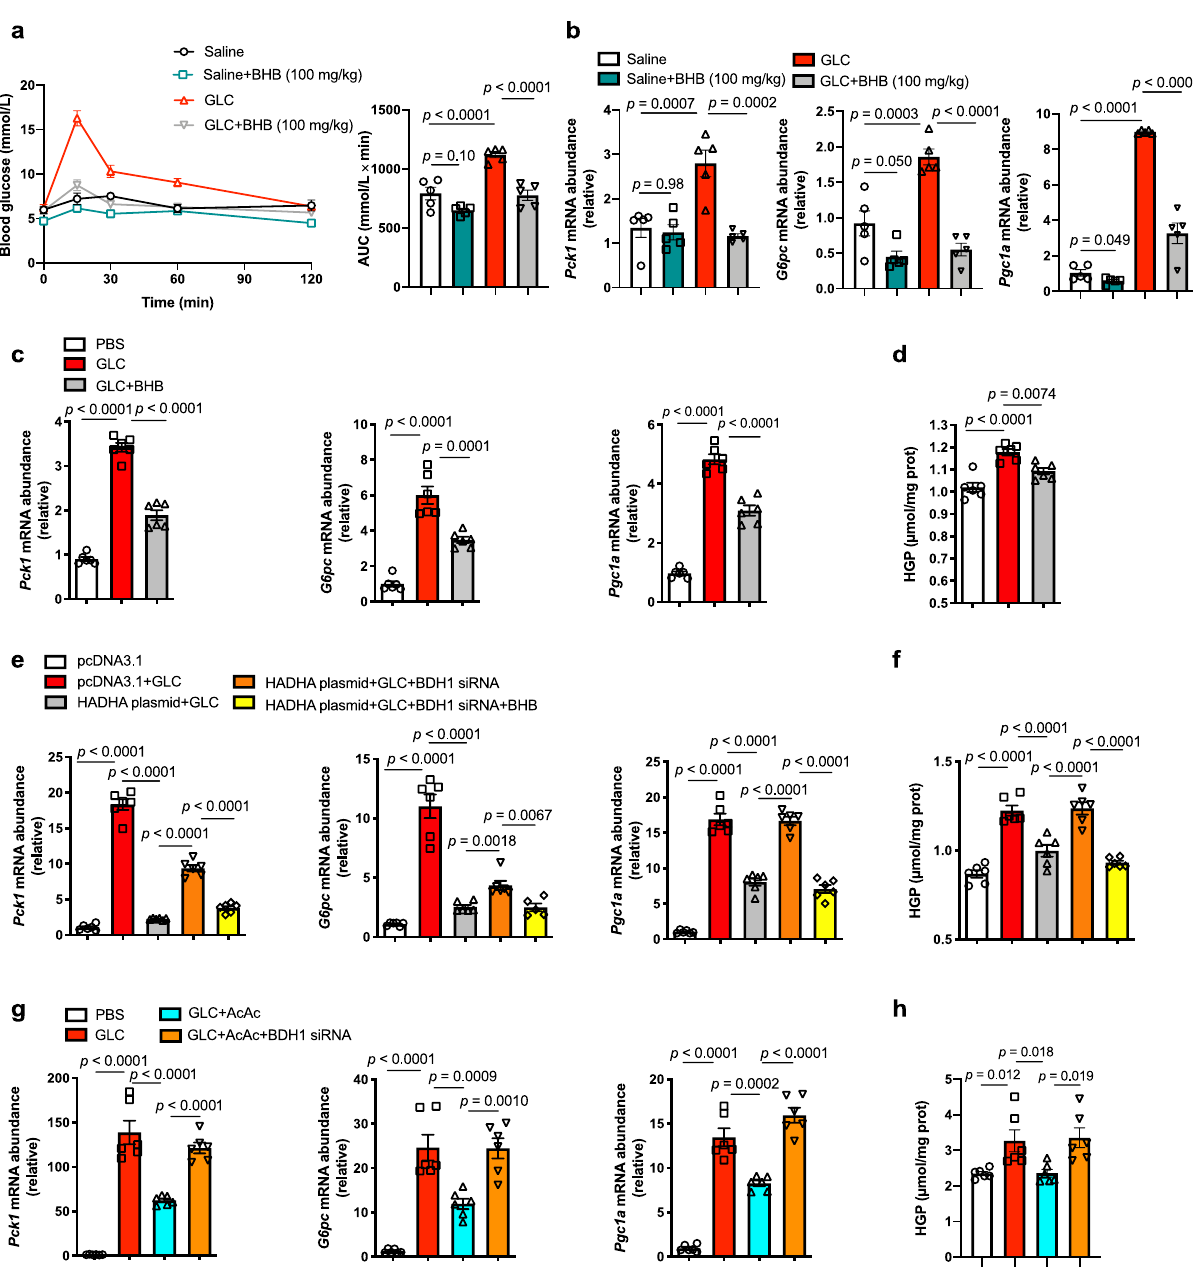
Fig. 3 BHB was responsible for the inhibitory effect of HADHA on hepatic gluconeogenesis. a Blood glucose levels in normal mice subjected to glucagon challenge (2 mg/kg) and those with BHB treatment (100 mg/kg). AUC is indicated on the right ( n = 5). b mRNA levels of Pck1 , G6pc and Pgc1a in the livers of the mice in a ( n = 5). c mRNA abundance of Pck1 , G6pc and Pgc1a in glucagon-stimulated (100 nM, 1 h) primary hepatocytes treated with or without BHB (400 μ M, 6 h, n = 5). d HGP from the hepatocytes in c ( n = 6). e Relative mRNA abundance of Pck1 , G6pc and Pgc1a in HADHA-overexpressed primary hepatocytes transfected BDH1 siRNA with or without BHB pretreatment (400 μ M, 6 h), 100 nM glucagon stimulation for 1 h ( n = 6). f HGP from the hepatocytes in panel e ( n = 6). g Relative mRNA abundance of Pck1 , G6pc and Pgc1a in AcAc pretreated (400 μ M) primary hepatocytes with or without BDH1 siRNA transfection ( n = 6). h HGP from the hepatocytes in g ( n = 6). AcAc acetoacetate, AUC area under the curve, BHB β -hydroxybutyrate, GLC glucagon, HGP hepatic glucose production, PBS phosphate buffer saline. Values represent mean ± SEM. Statistical differences were determined by one-way ANOVA. Source data are provided as a Source Data fi (Fig. 4g). These results suggest that HADHA and BHB promoted a BDH1-dependent manner (Fig. 4d), and BHB addition protected FOXO1 nuclear exclusion by enhancing its phosphorylation and FOXO1 phosphorylation against glucagon (Fig. 4e). In contrast acetylation. to phosphorylation regulation, deacetylation ensures the nuclear retention of FOXO1 28 . HADHA overexpression preserved FOXO1 acetylation in a BDH1-dependent manner (Fig. 4f). In BHB selectively inhibited HDAC7 to preserve FOXO1 acetylation . contrast, HADHA knockdown potentiated glucagon-mediated FOXO1 deacetylation, which was prevented by BHB repletion